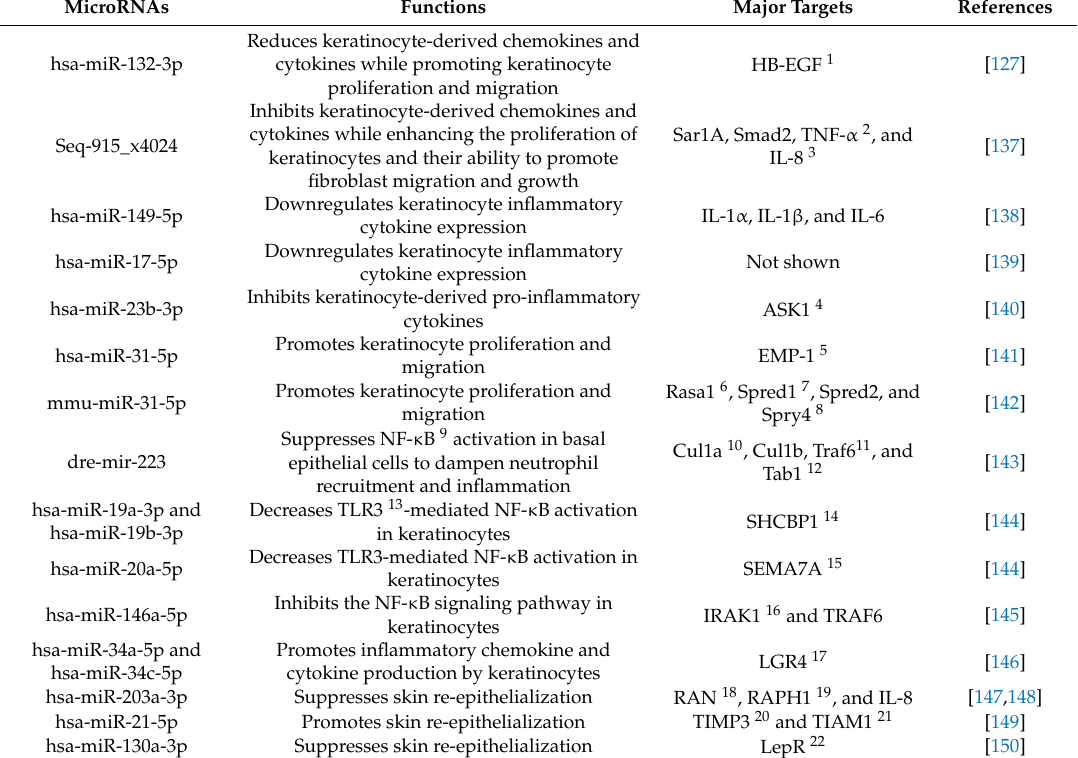
Table 2. MicroRNAs regulating keratinocyte immune functions in normal and chronic